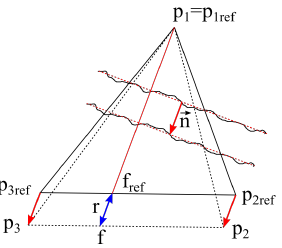
Figure 4. Labeled regions with triangles with principal strains being larger than a threshold are merged together.